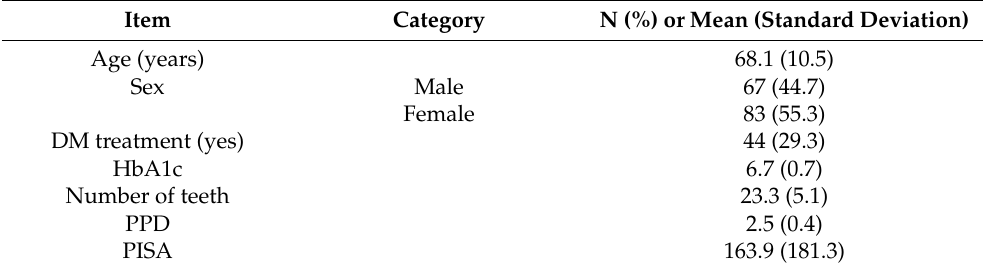
Table 1. Demographic data (N = 150).